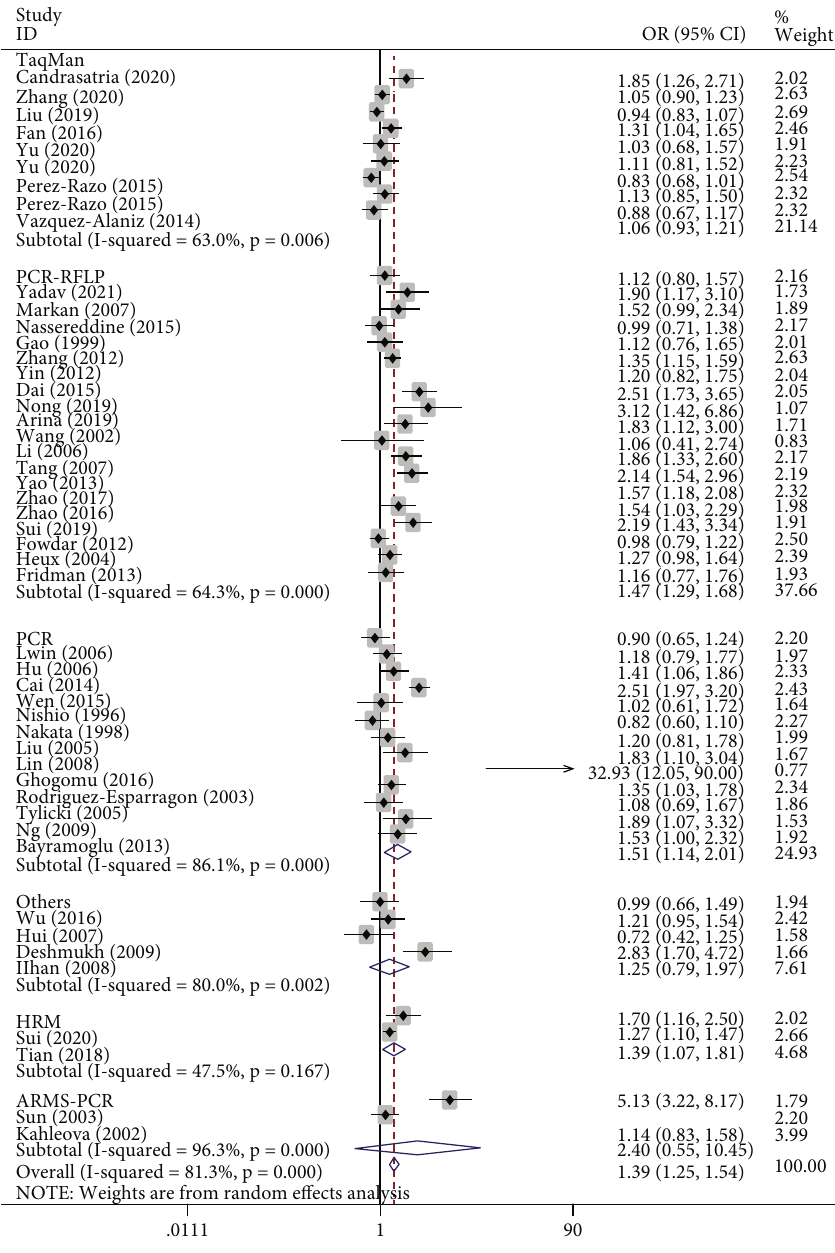
Figure 7: T-allele frequencies for the MTHFR gene rs1801133 polymorphism among cases/controls strati fi ed by subgroups in T-allele vs. C- allele model in genotype method subgroup by random-e ff ect